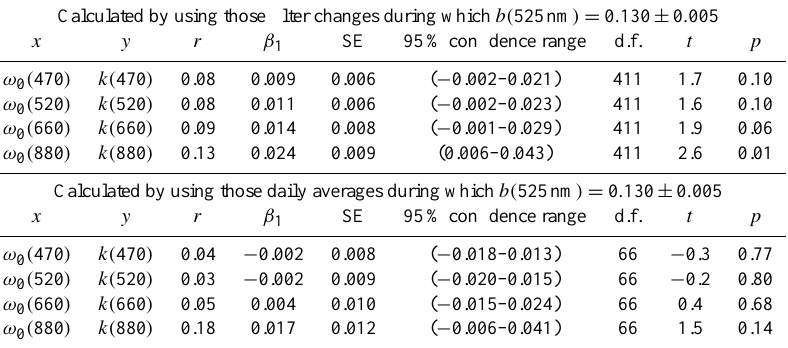
Table 4. Regression statistics ( y = β 1 x + β 0 ) of compensation parameter vs. single-scattering albedo at a limited backscatter fraction range. Detailed column description as in Table